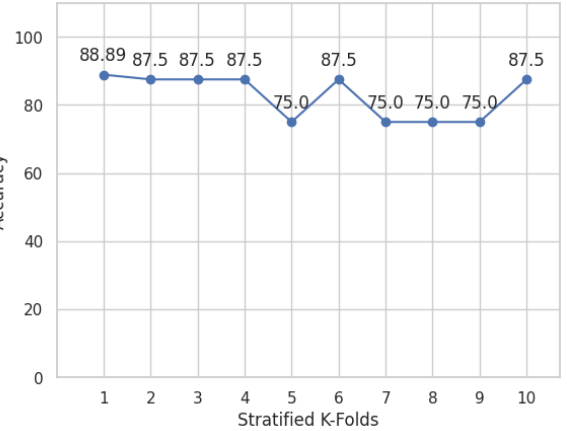
Figure 3. The classification accuracies of the LR model using the stratified ten-fold cross-valida-